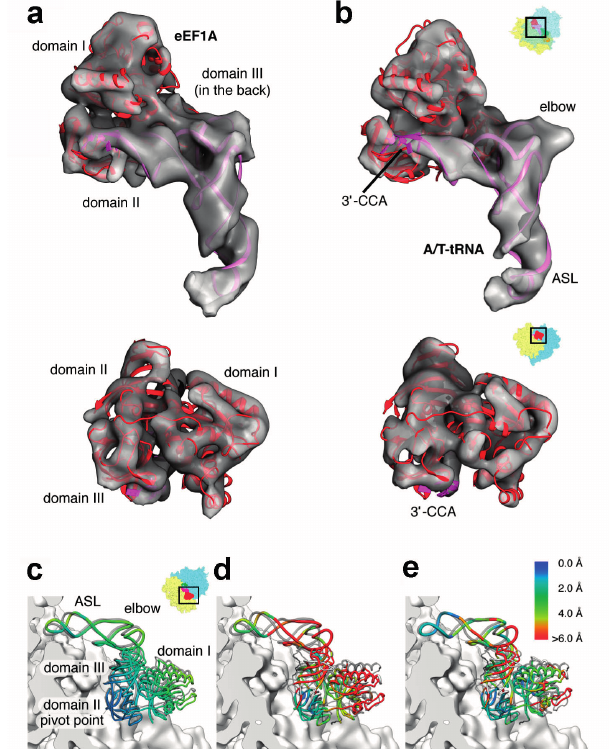
Figure 6. Comparison of mammalian and bacterial ternary complexes. CryoEM maps of eukaryotic ( a ) codon sampling and ( b ) GTPase activation steps. Fitted archaeal aEF1 α (PDB 3VMF [148]) and A/T tRNAs (ASL part from PDB 4V5L [131], body from PDB 1TTT [11]) are shown in red and pink ribbons, respectively; ( c ) Superposition of codon sampling (grey) and GTPase activation state ternary complexes after alignment of 40S subunits. Superposition of bacterial GDPCP stalled ternary complex, in grey (PDB 4V5L [131]) with eukaryotic ( d ) codon sampling and ( e ) GTPase activation state ternary complexes after alignment of 18S/16S rRNA’s conserved parts (the electron density corresponding to the 40S subunit surface is shown in white); ( e ) The relative orientations of factor and tRNA diverge in the two states of the eukaryotic decoding complex, as well as in their bacterial counterpart, which leads to a different interaction mode with the ribosome. The largest differences are observed in the tRNA elbow region due to interactions with the SRL and H89 from the large subunit, interactions not observed in bacteria. Measured distances (in Å) between the ternary complexes shown in panels ( d , e ) are color coded and shown on the right side of panel. (Figure adapted from [146], Copyright 2014